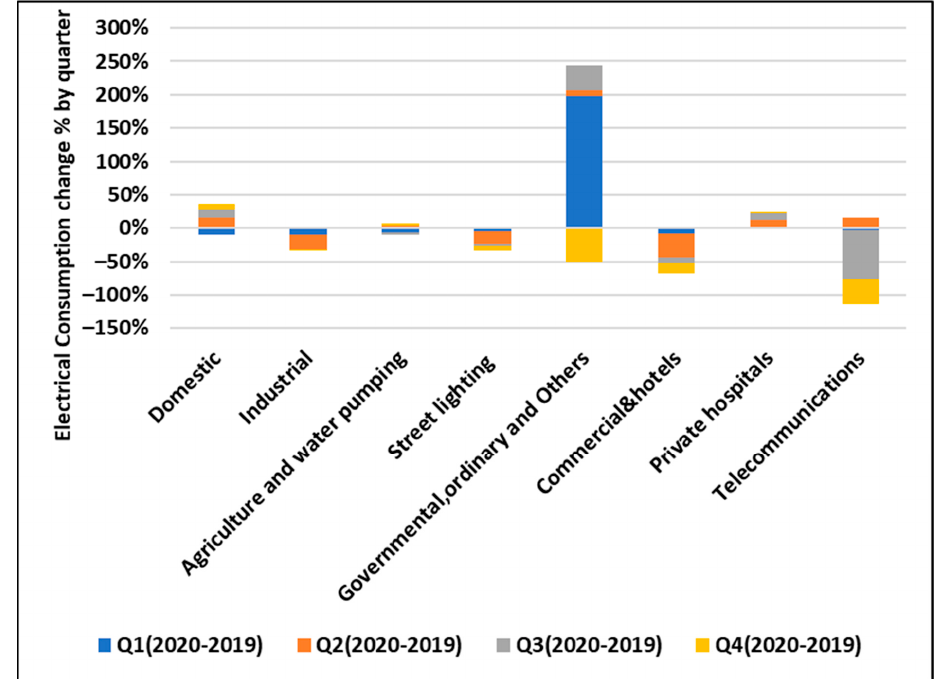
Figure 10. Change in electricity consumption in JEPCO’s region by quarter between 2019 and 2020.